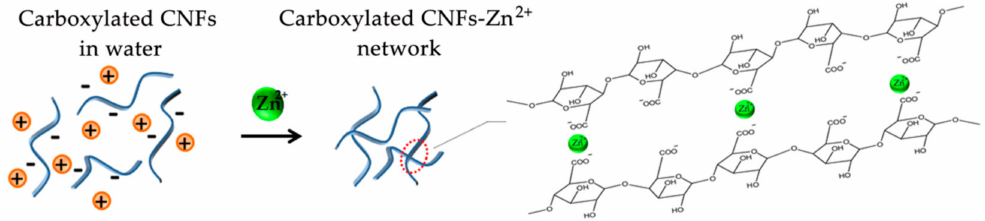
Figure 4. Schematic illustration of carboxylated CNFs crosslinking with Zn 2+ for gelation.